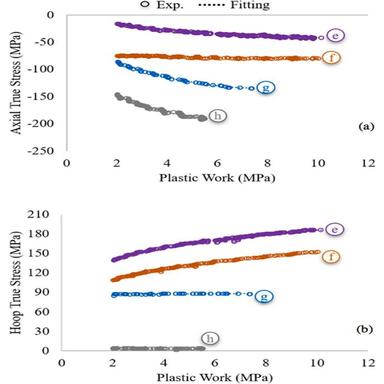
The calculated principal stresses for different levels of plastic work for tension-compression deformation modes: a) Axial stress and b) Hoop stress with respect to the plastic work (The experimental data were fitted using polynomial functions).